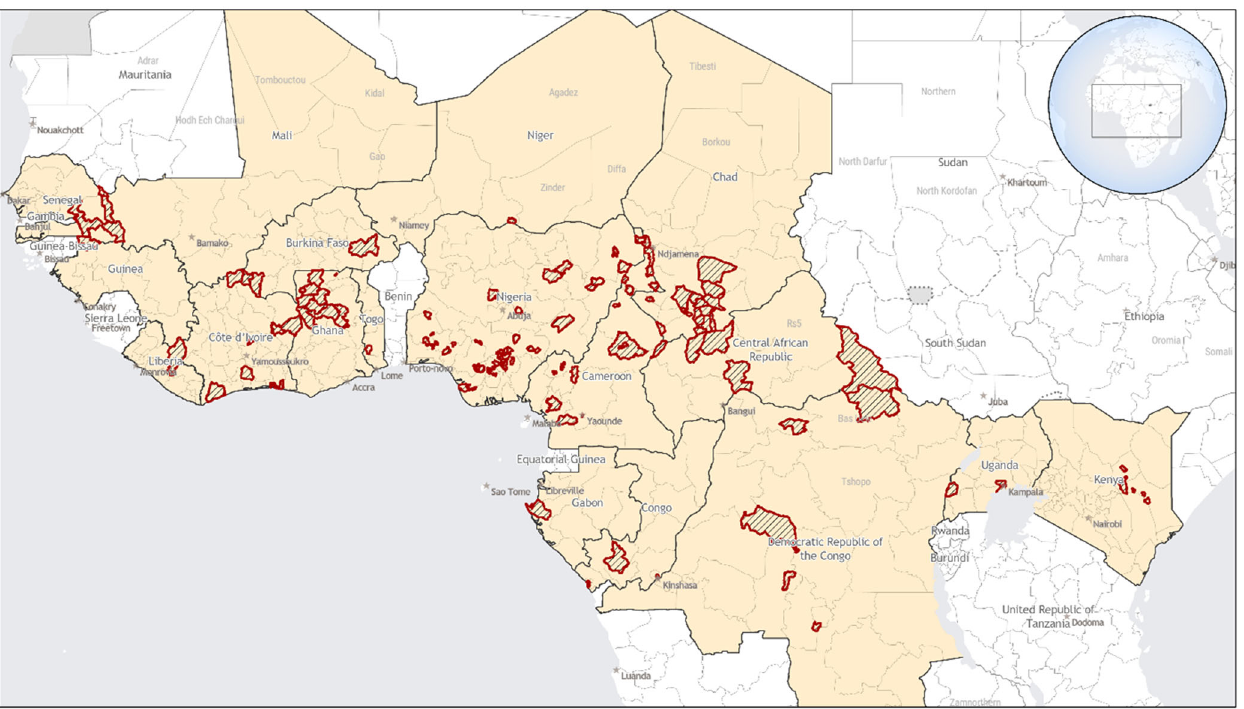
Fig. 1 Yellow fever disease cases — Africa, September 2020-March 2022. Areas with con fi rmed and probable yellow fever disease cases are outlined in